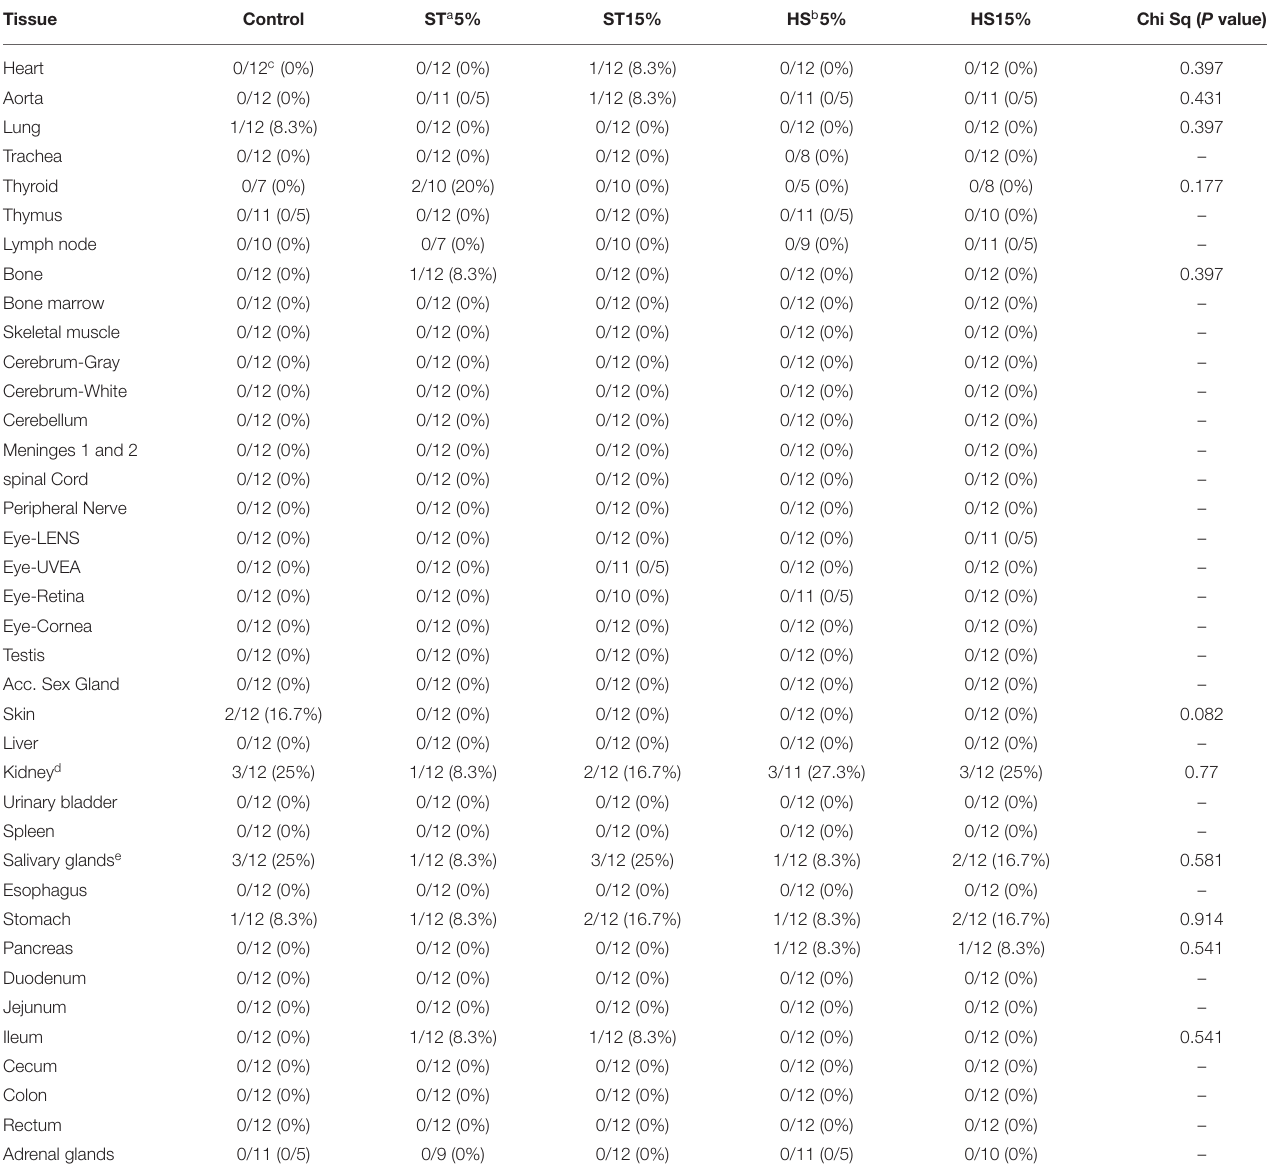
TABLE 2 | The pathology report for male mice fed normal mouse chow or chow supplemented with either ‘Stanley’ plum at 5 and 15% or ‘HoneySweet’ plum at 5 and 15%. Tissue